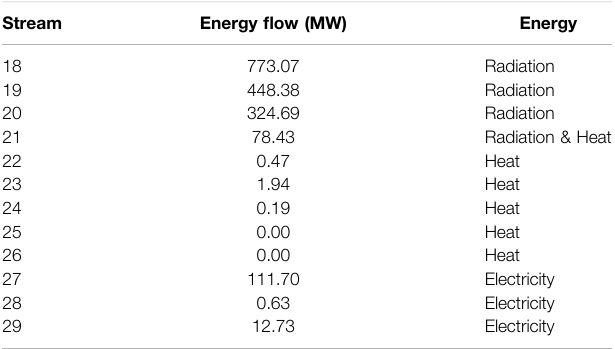
TABLE 7 | Radiation, heat, and electricity fl ows at the design point (see Figure 1B